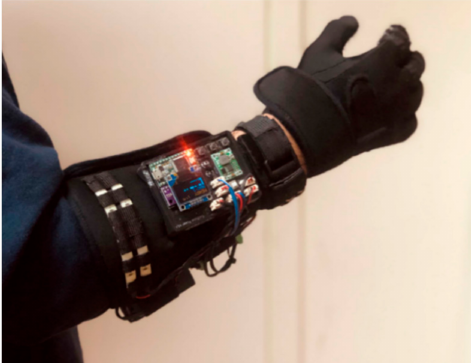
Figure 7. Portable exoskeleton glove with soft structure [73] (Open